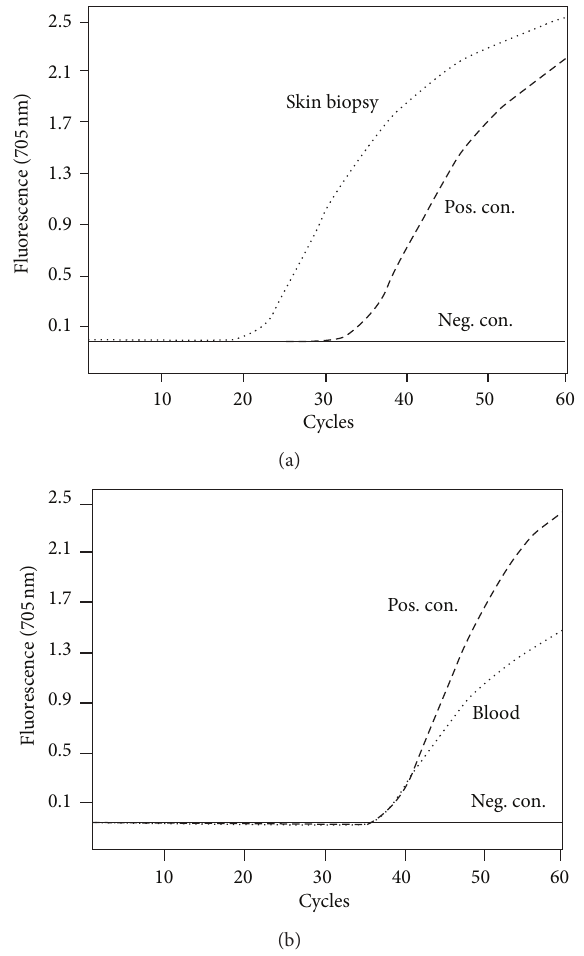
Figure 5: Bartonella quintana specific RT-PCR analysis of DNA extracts of skin biopsy (a) and blood